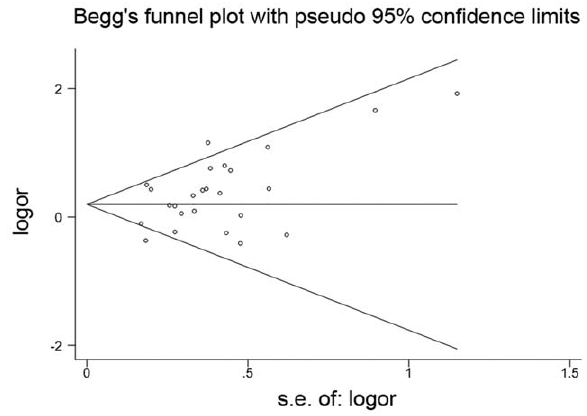
Figure 3. Begg’s Funnel plot of NTD risk associated with the maternal MTHFRC677T polymorphism (TT vs. CC + CT) in overall populations. Each point represents a separate study for the indicated